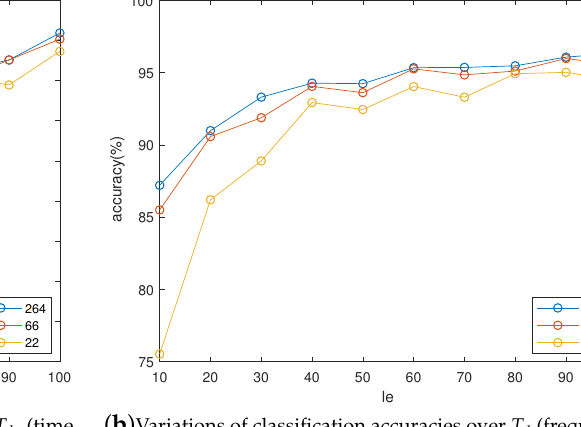
Figure 11. Classification accuracies of p-LapSVM over T d under LS1 ( k 1 = 6, γ K = 10 − 6 , γ M = 1, t 1 = 0.35, k 2 = 11, t 2 = 0.25, µ =